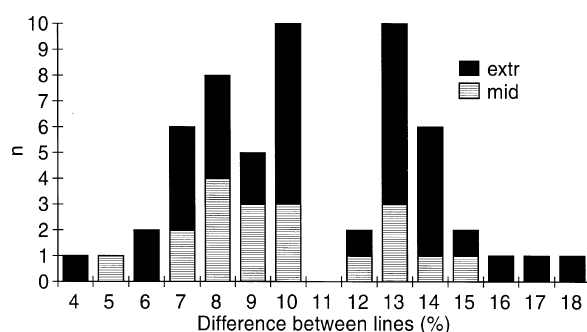
Fig. 11. Distribution of the distance between adjacent lines in the high frequency resolution dynamic spectra in percent ( mid : NCK and BDV, extr :